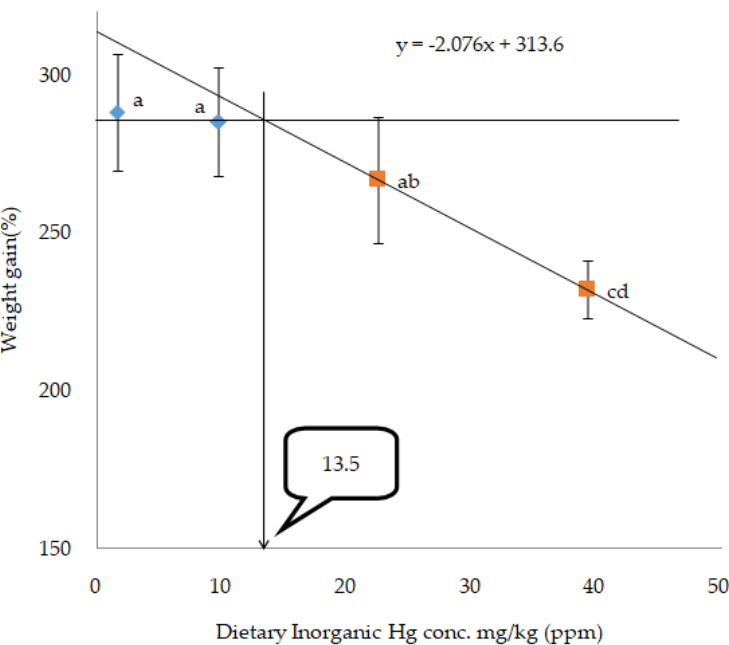
Figure 2. Broken-line analysis of weight gain (%) in olive flounder fed different levels of dietary inorganic mercury (HgCl 2 ) for eight weeks .